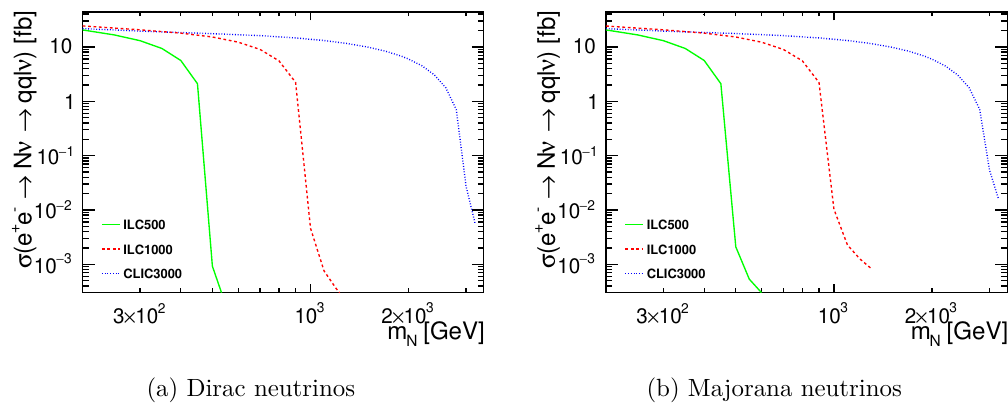
(b) Majorana neutrinos Figure 4. Reference scenario cross section for heavy Dirac neutrino (left plot) and Majorana neutrino (right plot) production, respectively, resulting in the qq‘ν final state at different collider setups: ILC500 (green solid line), ILC1000 (red dashed line) and CLIC3000 (blue dotted line). Polarisation (left-right for ILC, left-unpolarised for CLIC), ISR photons and beam spectra are included. The reference scenario assumes V 2 = 0 . 0003 . ‘N